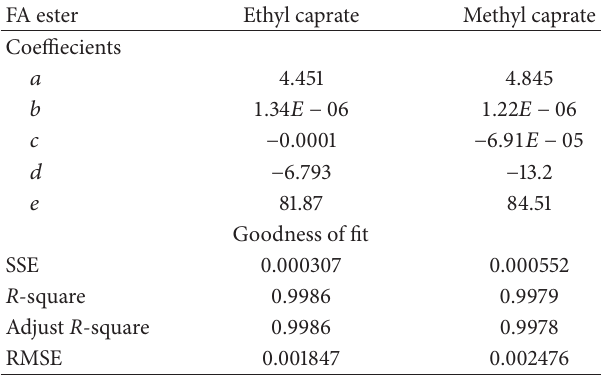
Table 4: 𝑘 𝑚 three-dimensional fitting